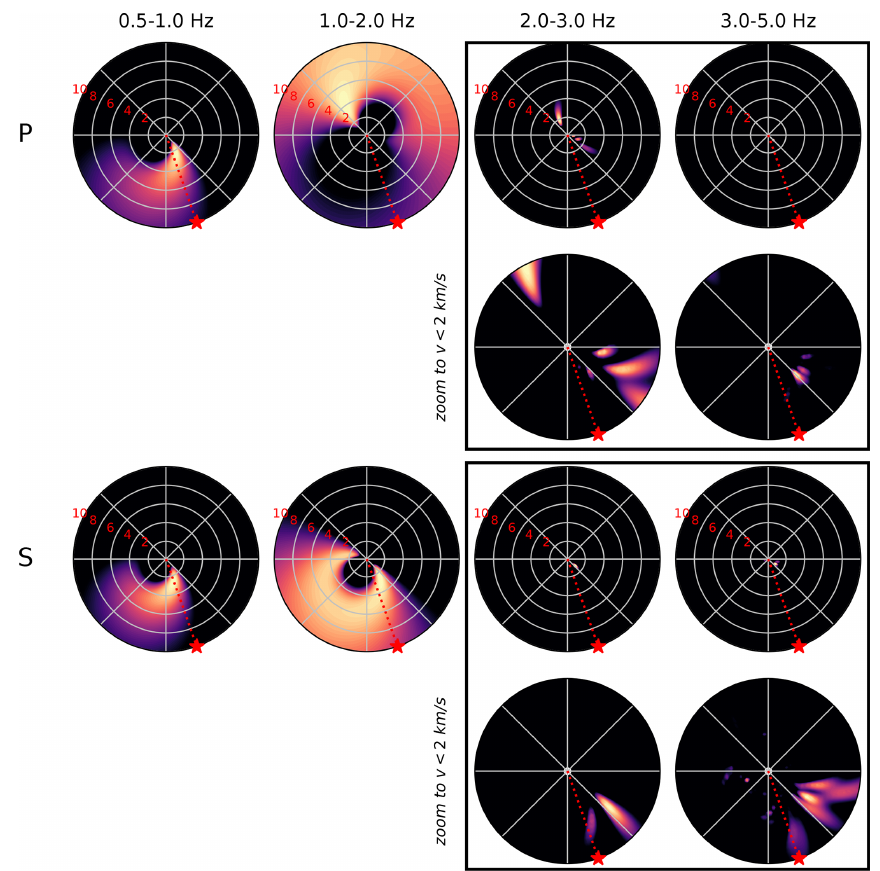
Figure 7. Beamforming results of the P and S waves recorded by the DAS array. The panel representation is the same as in Fig. 4. To be able to visually resolve the slow sources at frequencies greater than 2Hz, we add additional panels magnifying the region up to an apparent velocity of 2kms − 1